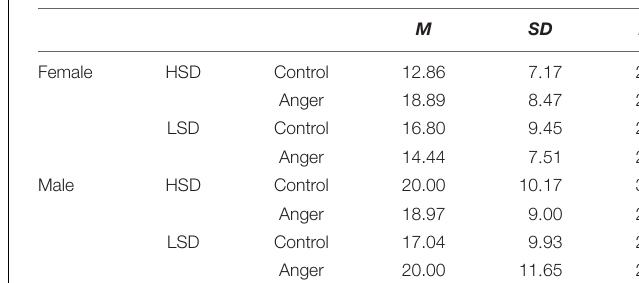
TABLE 1 | Means and standard deviations of trust by emotion, social distance and gender in Study